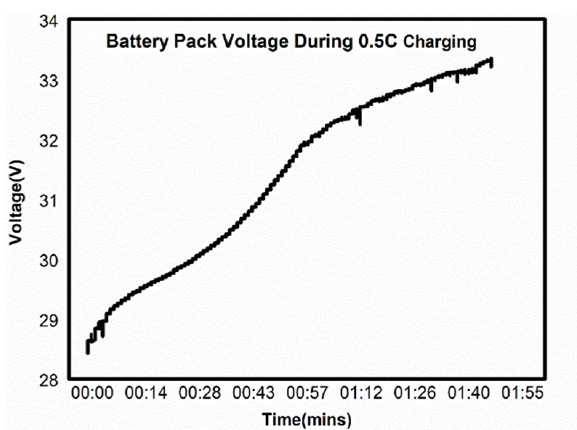
Figure 15. Charging